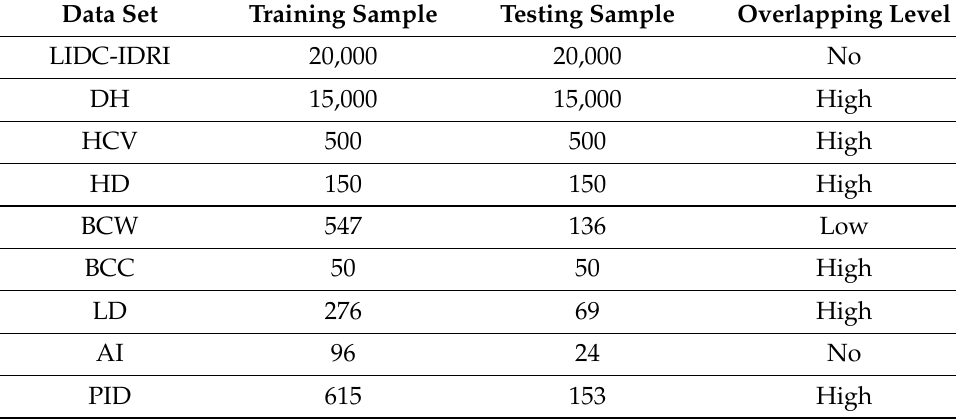
Table 3. Specification of real-world classification problems.